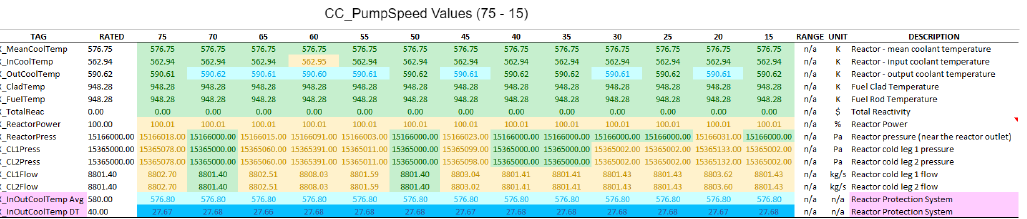
Figure 27. Simulated results